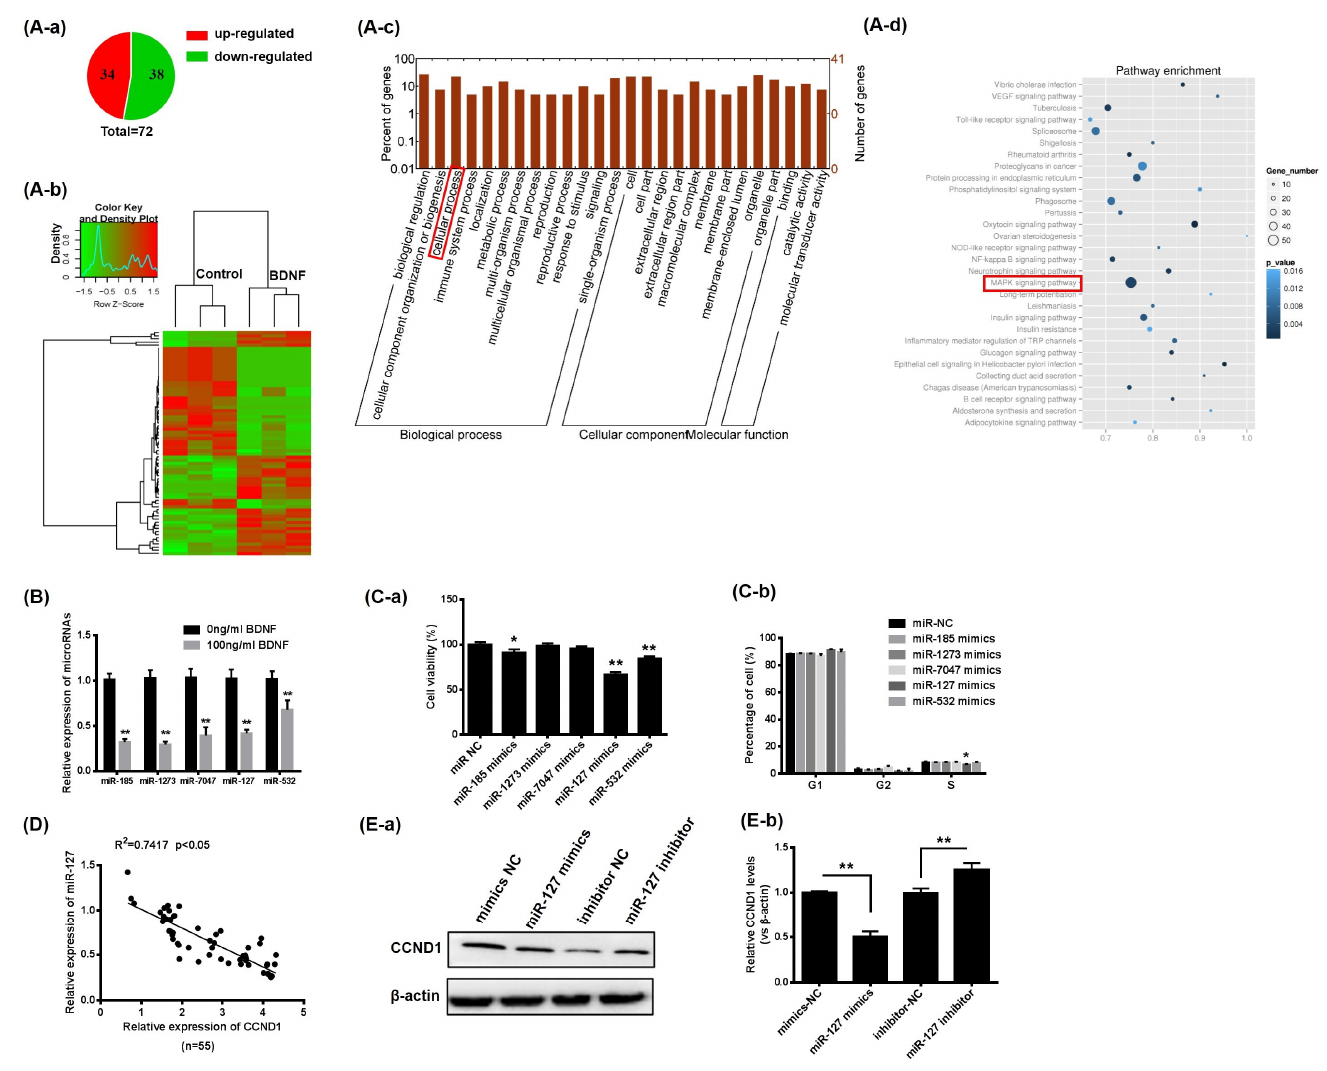
Figure 3. BDNF promotes GC proliferation, increasing CCND1 by downregulating miR-127. ( A ) miRNAs sequencing. ( A-a ) Proportion of upregulated and downregulated miRNAs in GCs. ( A-b ) Hierarchical cluster analysis of the expression pattern of significantly differentially-expressed miRNAs. The highest and lowest fold changes are marked from red to green. ( A-c ) Assessment of miRNA GO enrichment. ( A-d ) miRNA KEGG pathway investigation. ( B ) Relative mRNA expression levels of miR-185, miR-1273, miR-7047, miR-127 and miR-532 in GCs after BDNF (100 ng/mL) treatment for 24 h. ( C ) Transfection of porcine, with miRNAs mimics or negative control, for 24 h. CCK-8 assay performed to investigate the viability of GCs ( C-a ) and FASC performed to analysis the cell cycle ( C-b ). ( D ) Relationship of mRNA expression levels between miR-127 and CCND1. ( E-a , E-b ) Porcine GCs transfected with mimics or inhibitors of miR-127 for 24 h. Western blotting is performed to determine the protein expression level of CCND1. Date are presented as mean ± SD, n = 3; * p < 0.05, ** p < 0.01.